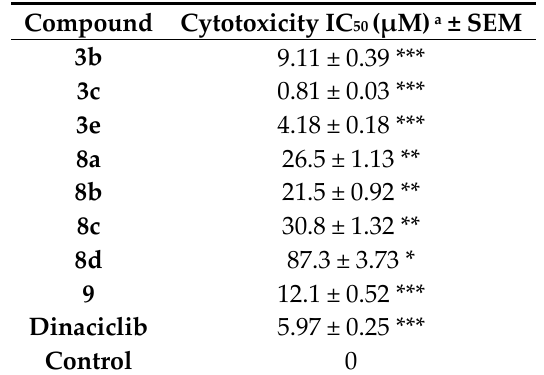
Table 3. Antiproliferative activity of the target compounds 3b, 3c, 3e, 8a–d , 9 , Dinaciclib , and the